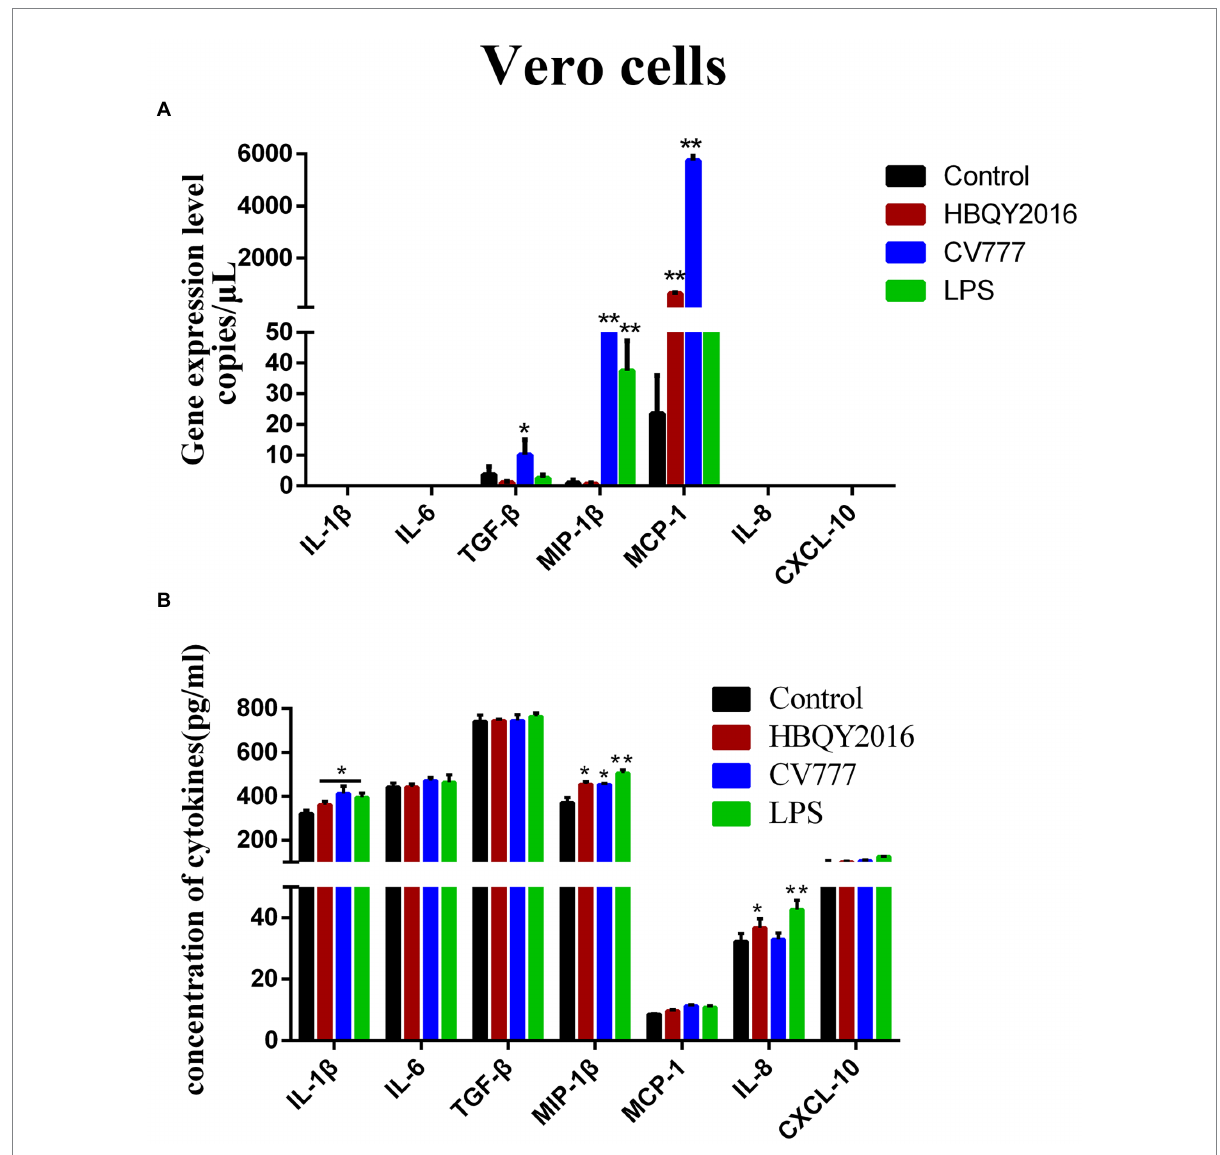
FIGURE 3 Cytokines expression in Vero cells infected with PEDV. (A) Changes of gene copies of IL-1 β , IL-6, TGF- β , MIP-1 β , MCP-1, IL-8, and CXCL-10 gene expression in Vero cells after PEDV infection. (B) Protein concentration of the cytokines secreted by PEDV-infected Vero cells. The supernatant of Vero cells was collected at 24 h after infection with 0.1 MOI PEDV, and the cytokine secretion level was detected by ELISA. *Represents a significant difference relative to the control group ( p < 0.05), **Represents an extremely significant difference relative to the control group ( p <